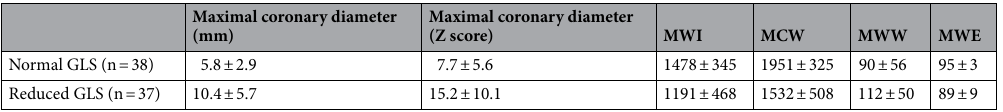
Table 2. Echocardiographic variables of KD/CADL children with normal strain or strain reduction. Values are mean (SD). GLS global longitudinal strain, MWI myocardial work index, MCW myocardial constructive work, MWW myocardial wasted work, MWE myocardial work efficiency.